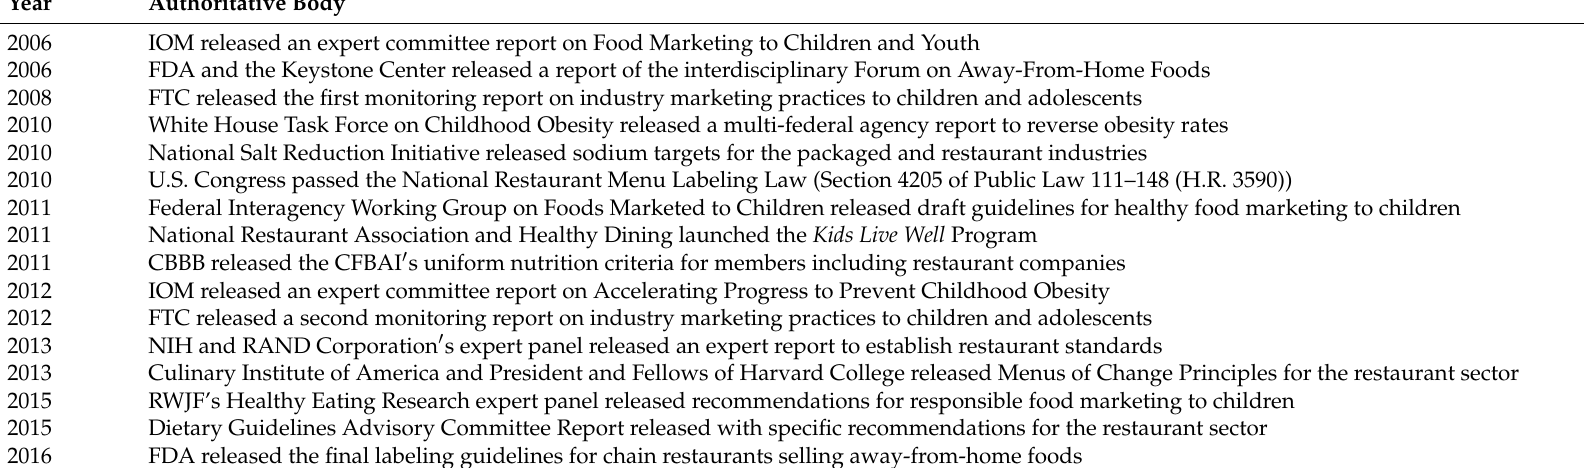
Abbreviations: Children (cid:48) s Food and Beverage Initiative (CFBAI), Council of the Better Business Bureaus (CBBB), Food and Drug Administration (FDA), Federal Trade Commission (FTC), Institute of Medicine (IOM), National Institutes of Health (NIH), National Restaurant Association (NRA), Research and Development (RAND) Corporation and Robert Wood Johnson Foundation (RWJF). Note: In 2016, the IOM was renamed the Health and Medicine Division (HMD) of the National Academies of Sciences, Engineering and